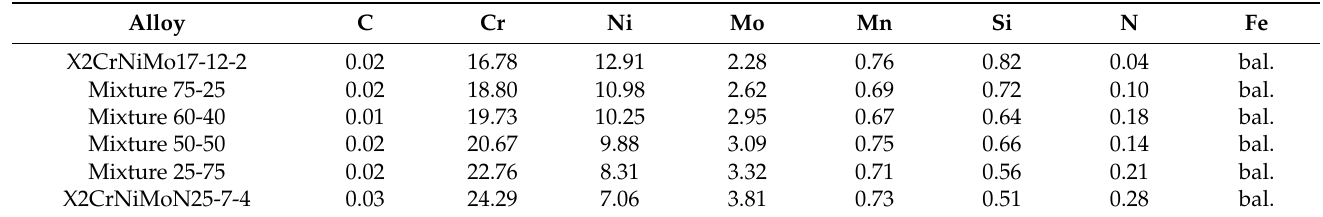
Table 4. Chemical composition of the as-built parts using the initial powders and the various powder mixtures was determined using S-OES (in mass %).